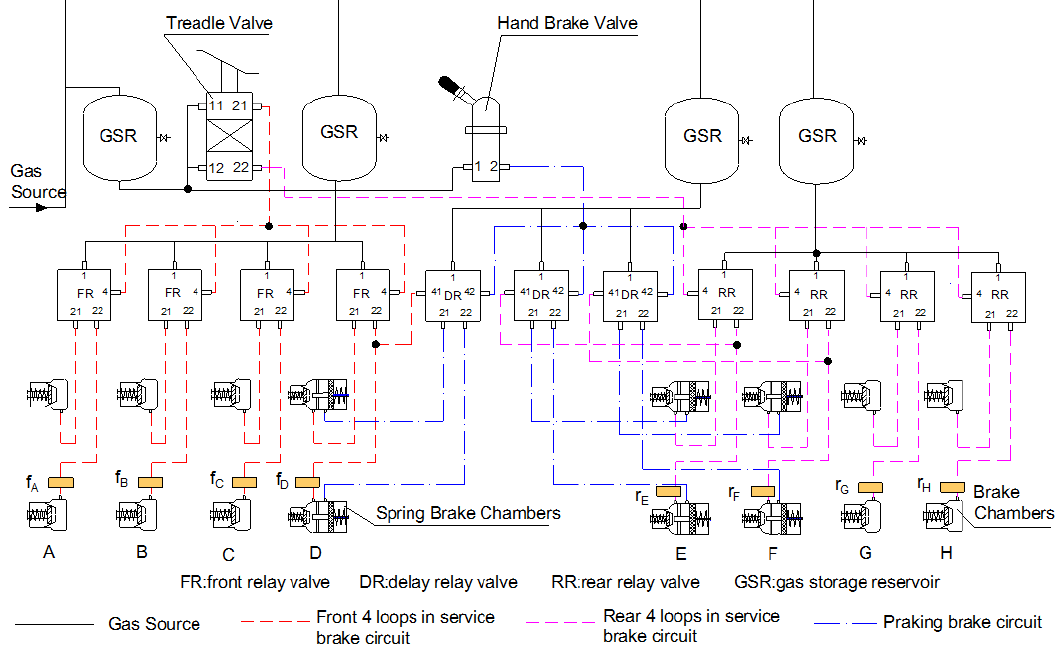
Figure 6. Layout of gas transmission path of the PBS on the test bench. GSR: gas storage reservoir; FR: front relay valve; DR: delay relay valve; RR: rear relay valve. A, B, C, D and E, F, G, H are front four loops and rear four loops in the service brake circuit,respectively.